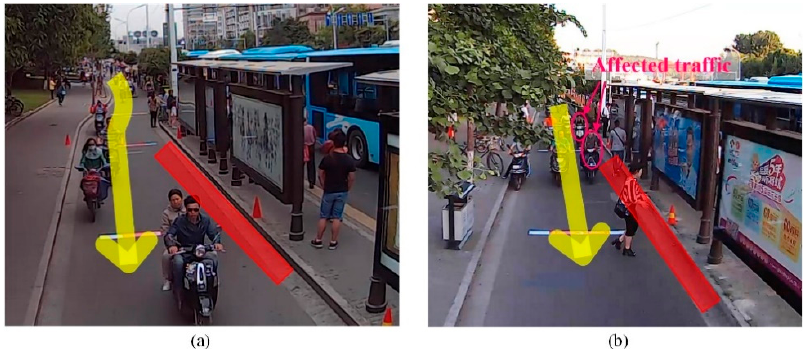
Figure 7. Comparison of real bicycle flow operating cases at ( a ) a curbside stop and ( b ) a bus bay. (yellow arrows indicate the flow trajectories, while red rectangles is the influence area of a platform).